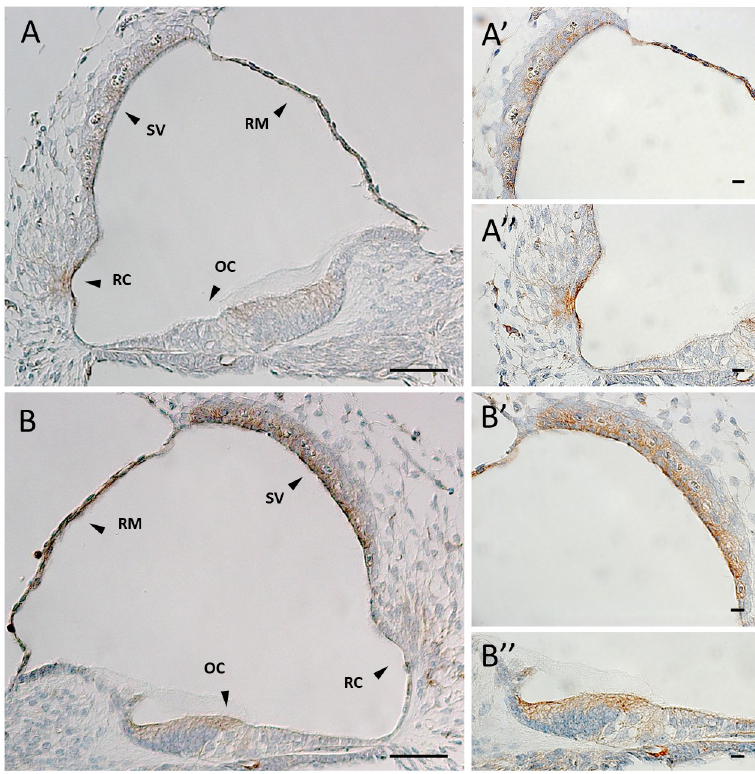
Fig 4. Diaph2 expression in P5 wild-type mouse cochlea. Brown indicates positive staining. ( A ) Scala media of the middle turn of cochlea. Scale bar 100 μ m. ( A’-A” ) Higher magnification of the stria vascularis and of the outer sulcus shown in A. Scale bar 10 μ m. ( B ) Scala media of the basal turn of cochlea. Scale bar 100 μ m. ( B’-B” ) Higher magnification of the stria vascularis and of the organ of Corti shown in B. Scale bar 10 μ m. Arrowheads point to: organ of Corti (OC), root cells (RC), Reissner’s membrane (RM), stria vascularis